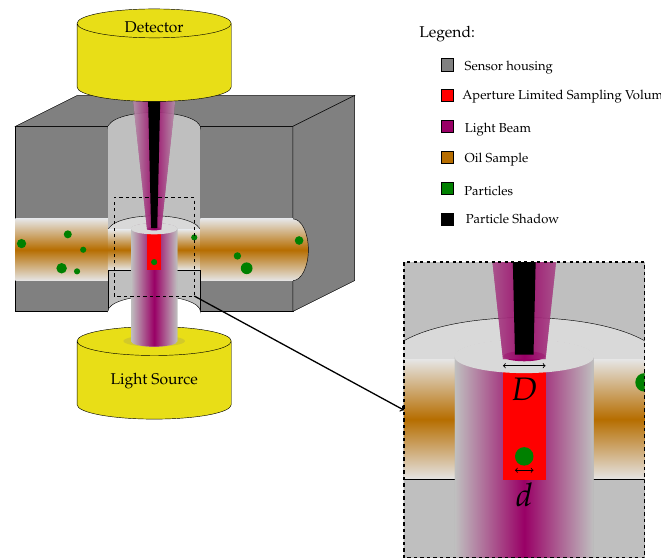
Figure 1. Illustration of optical particle counter (OPC) working principle, where an opaque particle present in the sampling volume results in a light obscuration shadow effect. The insert shows a circular aperture and a spherical particle with diameters D and d , respectively. Flow direction is from left (inlet) to right (outlet). The size of particles and aperture are greatly exaggerated in the